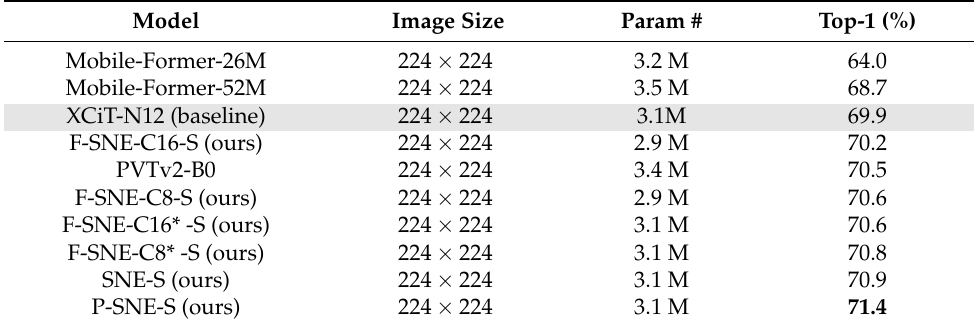
Table 2. Proposed models were evaluated on ImageNet classification task. The number of parameters was constrained to be below 4 M to be compared to the small (S) models.